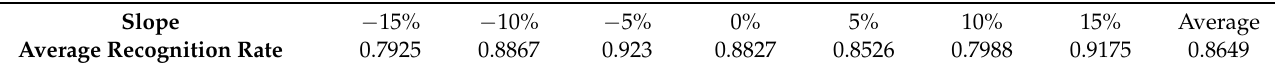
Table 4. Average recognition rates in 7 slopes of the BP neural